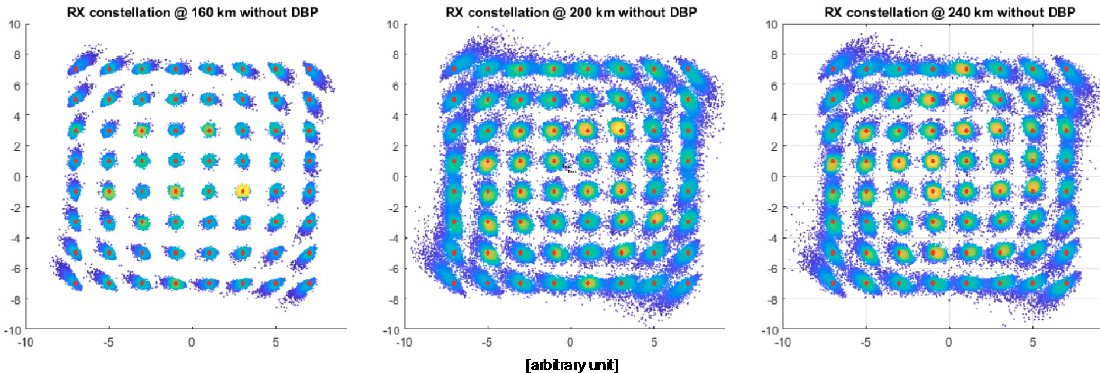
Figure 6. Signal power distribution in fiber with distributed Raman amplification.